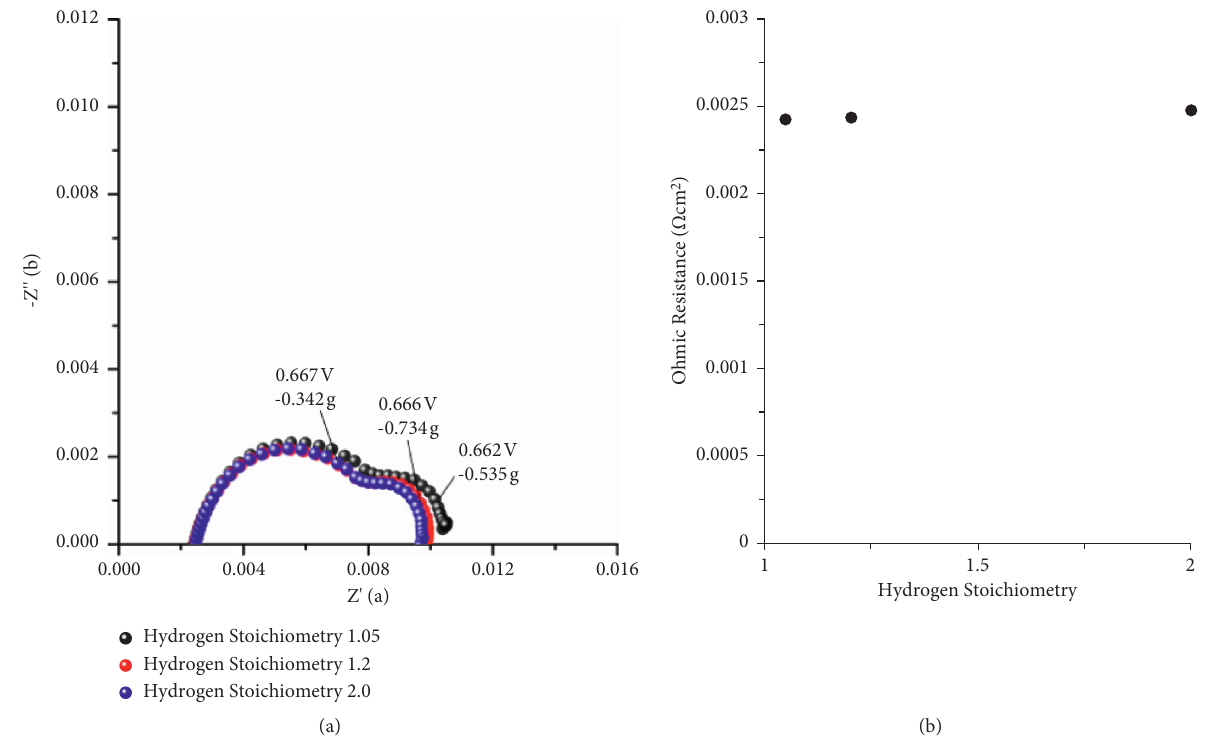
Figure 10: Effect of hydrogen stoichiometry on the voltage, water content in the fuel cell, EIS, and ohmic resistance (inlet gas temperature 75 ° C, inlet gas humidity 100%, and air stoichiometry 2.5). (a) EIS. (b) Ohmic resistance.